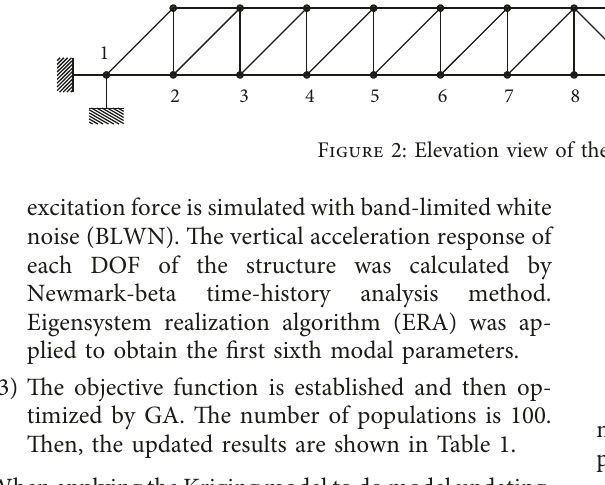
10 from two variables X (cid:29) 0 , 1 . (a) Simple random sampling. (b) Latin hypercube sampling. [ ]